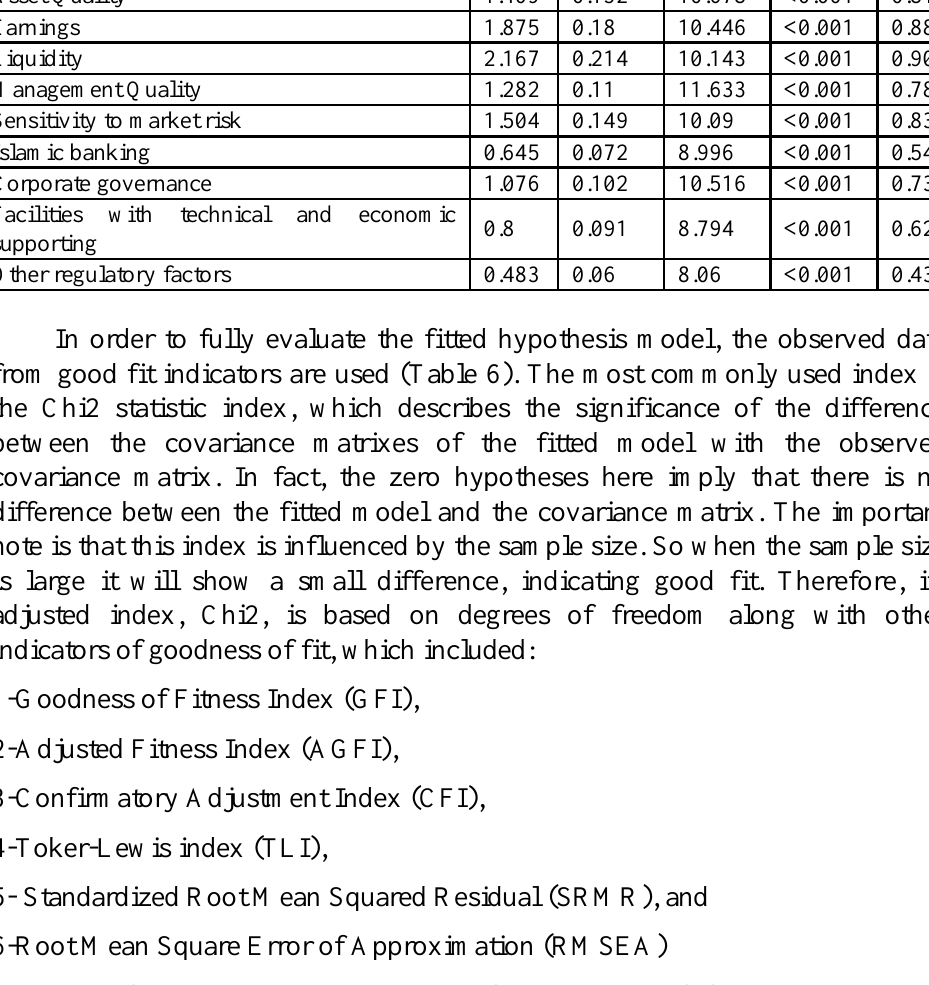
Figure 1. Ten-factor model of financial soundness indicators of